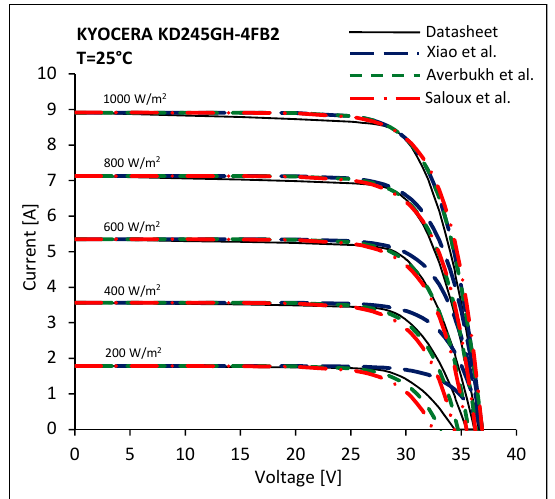
Figure 6. Comparison between the issued I-V characteristics of the Kyocera KD245GH-4FB2 at T = 25 °C and the characteristics calculated by means of the Xiao et al. the Averbukh et al. and the Saloux et al. models.